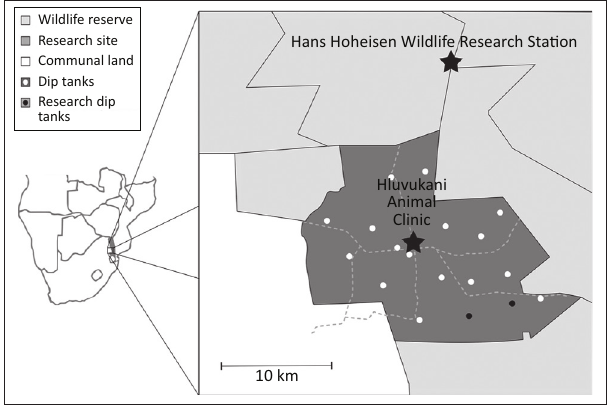
FIGURE 1: Map of the Mnisi research site. The sampling was done at the two research dip tanks indicated by black